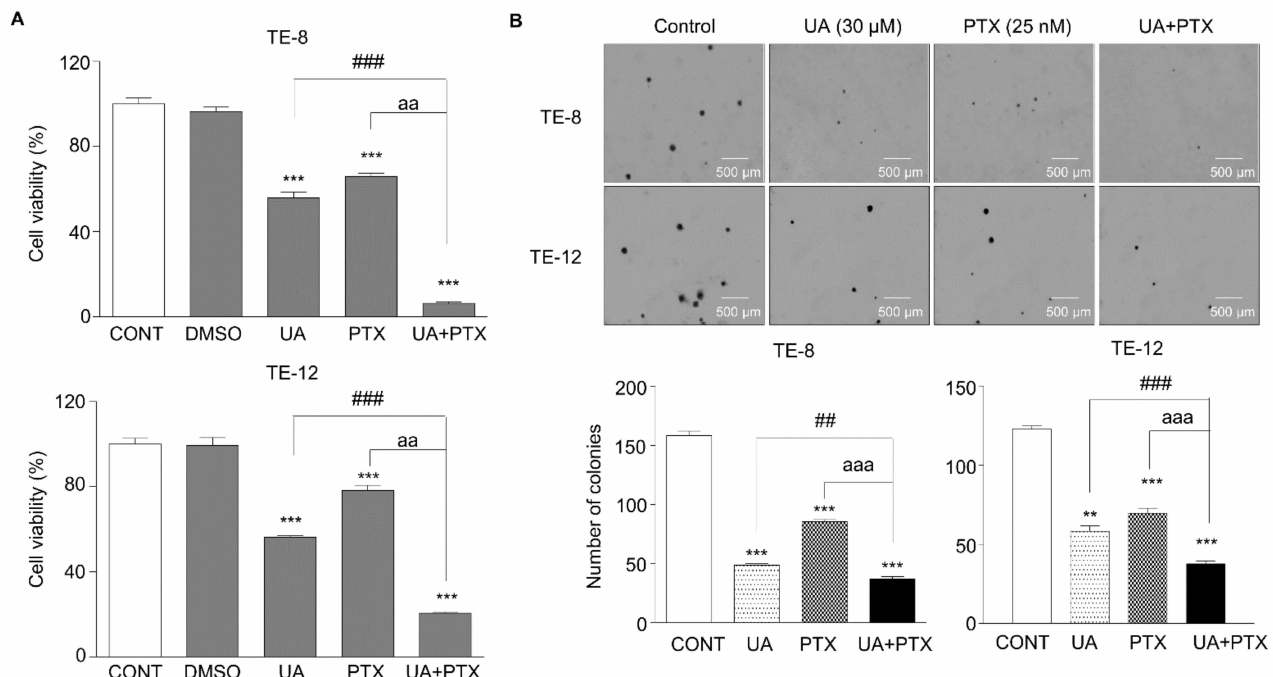
Figure 1. UA and PTX inhibited cell proliferation in ESCC cells. TE-8 and TE-12 cells were treated with UA 30 µ M, PTX 25 nM, or both. ( A ). Cell viability was assessed using the WST-1 assay. ( B ). A colony formation assay was performed to study cell proliferation. Images were taken by microscopy, and the colonies were counted in more than five areas per well. Data are the mean (SE) of >three independent experiments with triplicate dishes. *, compared with the control group; # , UA compared with the UA plus PTX combination group; a , PTX group compared with the UA plus PTX combination group. ## , aa , ** p < 0.01 and ### , aaa , *** p < 0.001. Scale bar: 500 µ m. CONT, control; DMSO, dimethyl sulfoxide; UA, ursolic acid 30 µ M; PTX, paclitaxel 25 nM; UA+PTX, combination treatment of ursolic acid 30 µ M and paclitaxel 25